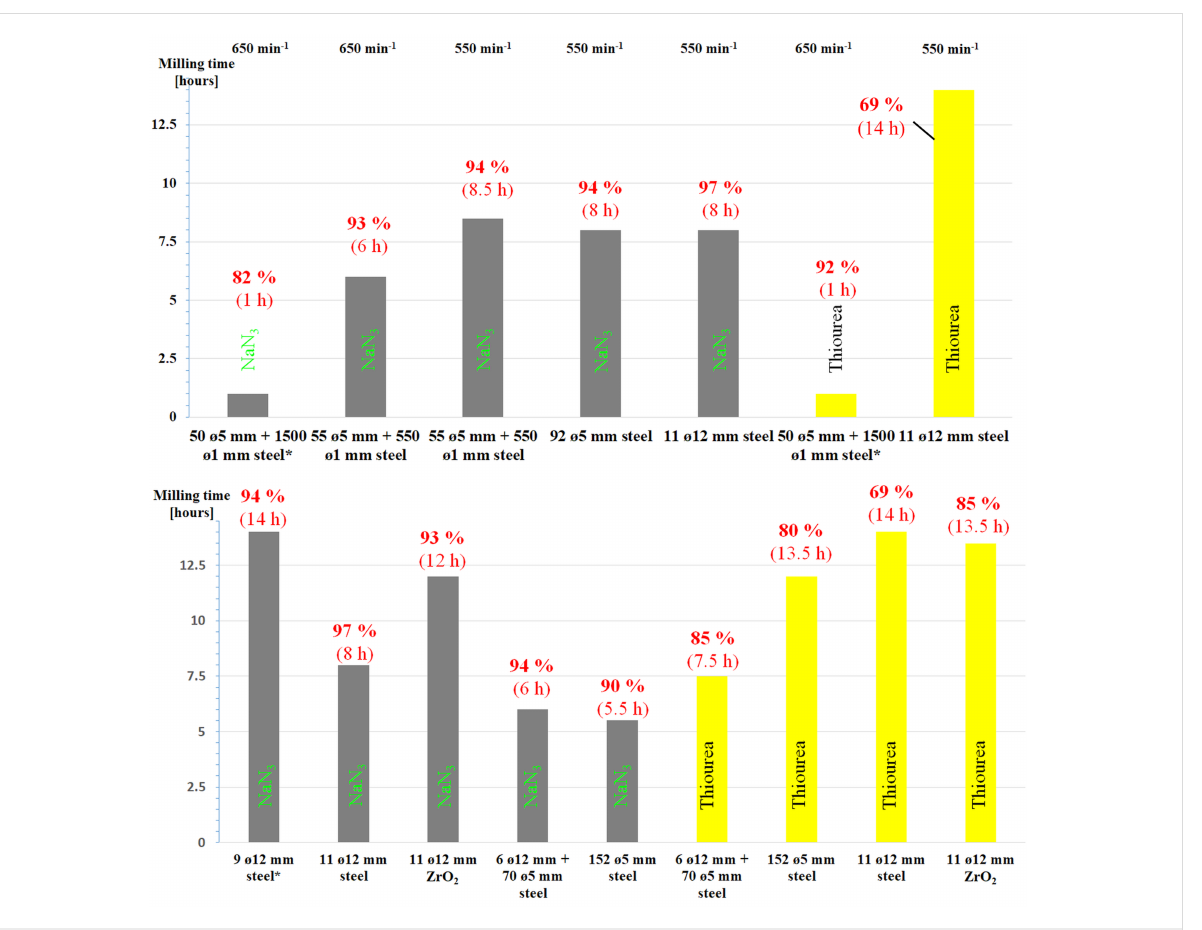
Figure 2: Effect of ball size on the reaction time to a full conversion of Ts- β -CD: a) reactions performed at constant total steel ball weight of ca. 45 g (*weight of steel balls ca . 70 g for comparison with [13]); b) the number (and size) of balls were combined to be equal to the volume occupied by 11 balls of ø 12 mm (ca. 10 mL) at 550 min − 1 (*weight of steel balls ca. 40 g kept similar to 11 zirconia balls of 12 mm in diameter (ø) for comparison). Values given on the graph bars indicate, respectively, the yield and the reaction time to achieve full conversion of the starting Ts- β